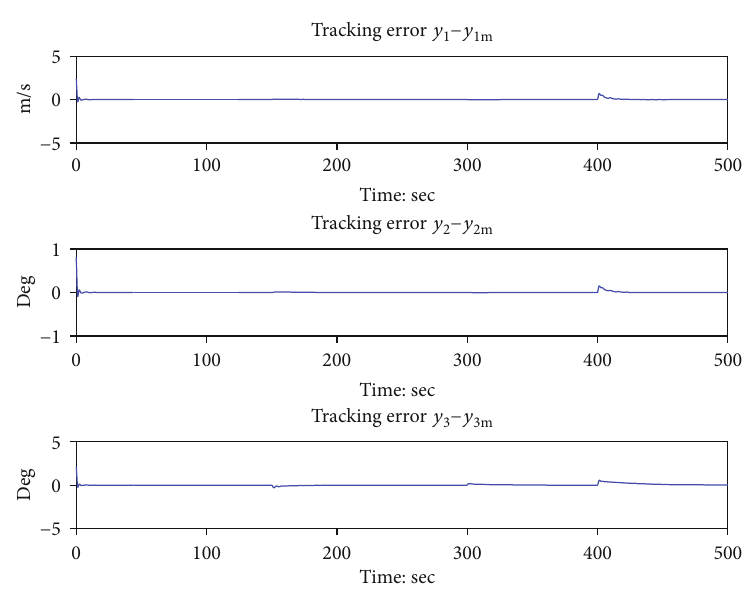
Figure 2: Tracking